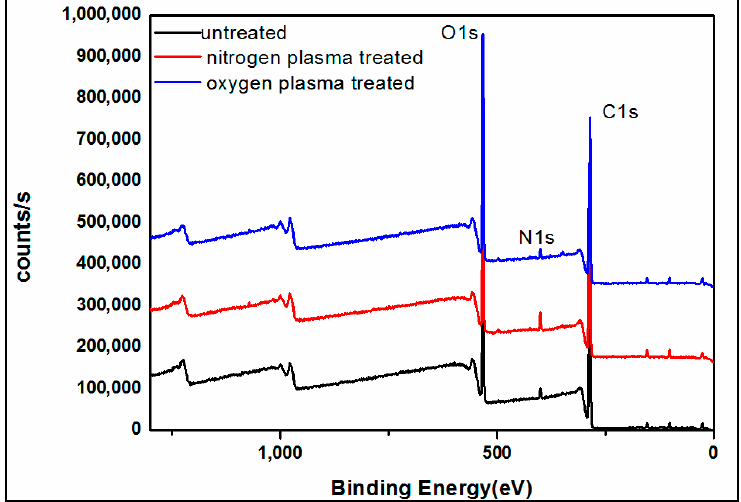
Figure 2. XPS full spectrum of untreated, nitrogen plasma-treated, and oxygen plasma-treated wood.